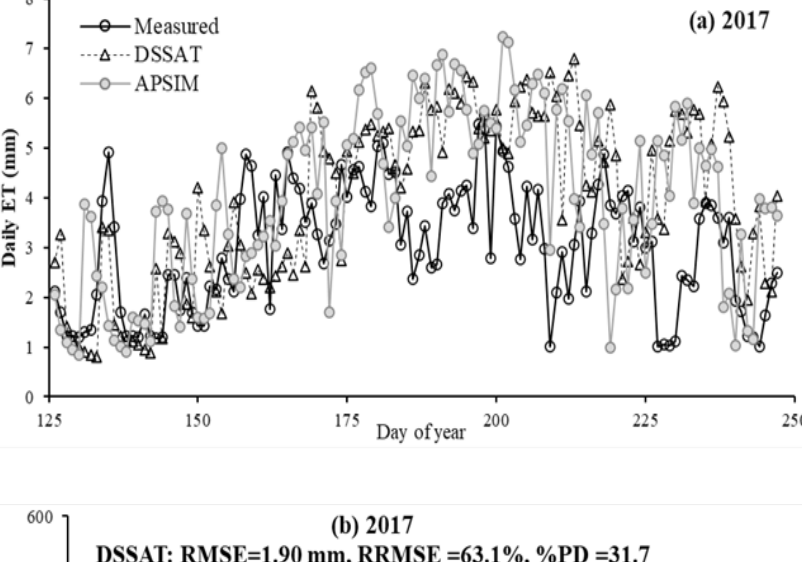
Figure 2. Comparisons of daily and cumulative seasonal ET-measured with eddy covariance (EC)- simulated by DSSAT and APSIM for calibration ( a , b ) during 2017 and validation ( c , d ) during 2018 growing seasons . 4. Conclusions Irrigation water management based on location-specific crop water demands (ET) vs. supply situations can significantly help enhance WUE for sustainable irrigated crop pro- duction systems. Cropping system models are easy to implement tools for estimating lo- cation-specific ET and crop production responses from soil and weather information. In this study comparing models for predicting location-specific simulation of cotton, overall, the DSSAT-CROPGRO and APSIM-OzCot models demonstrated the potential to reason- ably estimate cotton yields under irrigated conditions in the Mississippi Delta region. Both models showed similar performance predicting LAI and ET, but the prediction varied be- tween observed and simulated over two growing seasons. The simulation error statistics show that the models need improvement in simulating daily ET demands for applications in enhancing WUE in irrigated cotton systems in the Delta region. Author Contributions: Conceptualization, A.C. and S.S.A.; methodology, A.C. and S.S.A.; software, A.C. and S.S.A.; formal analysis, A.C. and S.S.A.; investigation, S.S.A.; resources, S.S.A.; data